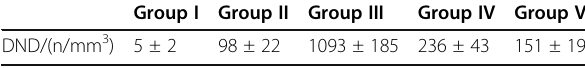
Table 1 Numerical results of